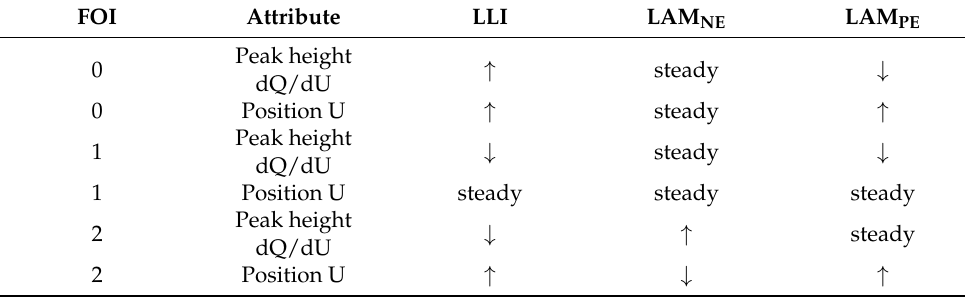
Table 3. FOI general trends of different aging mechanisms [50].